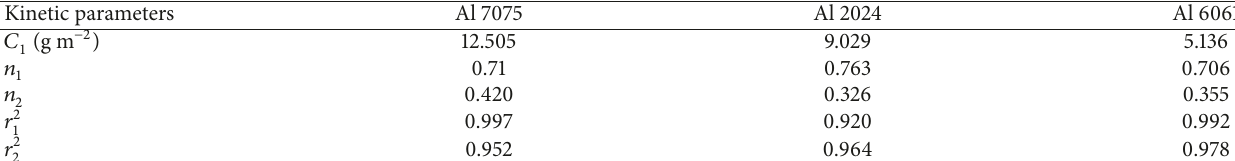
Table 3: Corrosion kinetic parameters for Al alloys in the Red Sea water. Kinetic parameters